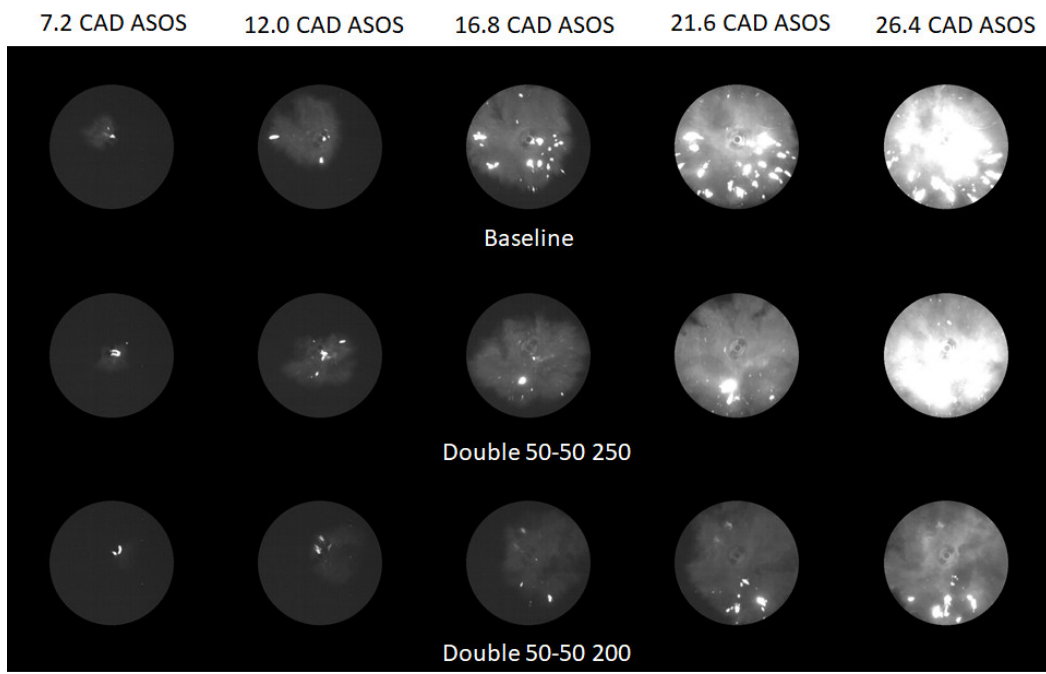
Figure 9 . Flame image sequence during the flame propagation stage for baseline and double injection 50-50 at two SOI (250 and 200 CAD BTDC).